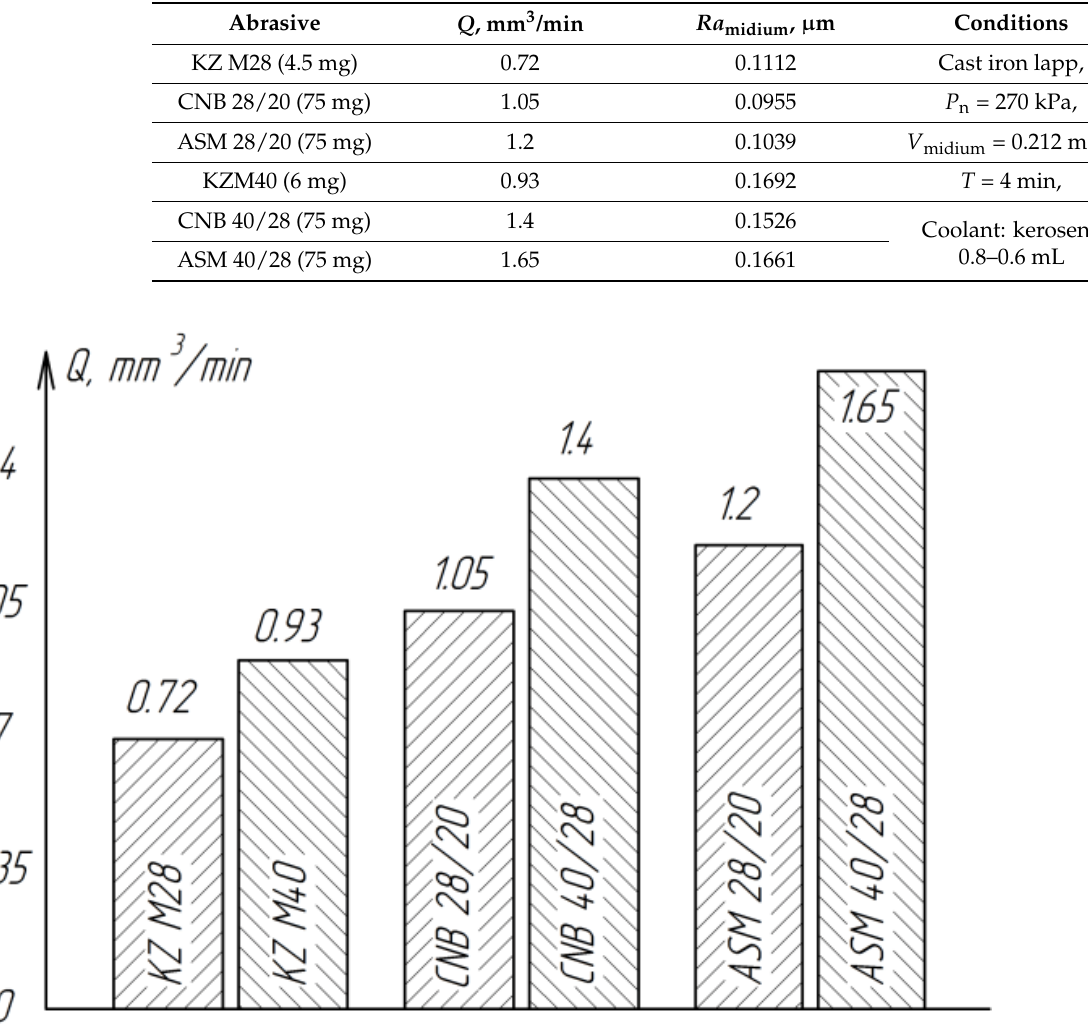
Figure 6. Influence of the type and grain size of the abrasive material on the processing performance of ZrO 2 ceramics.